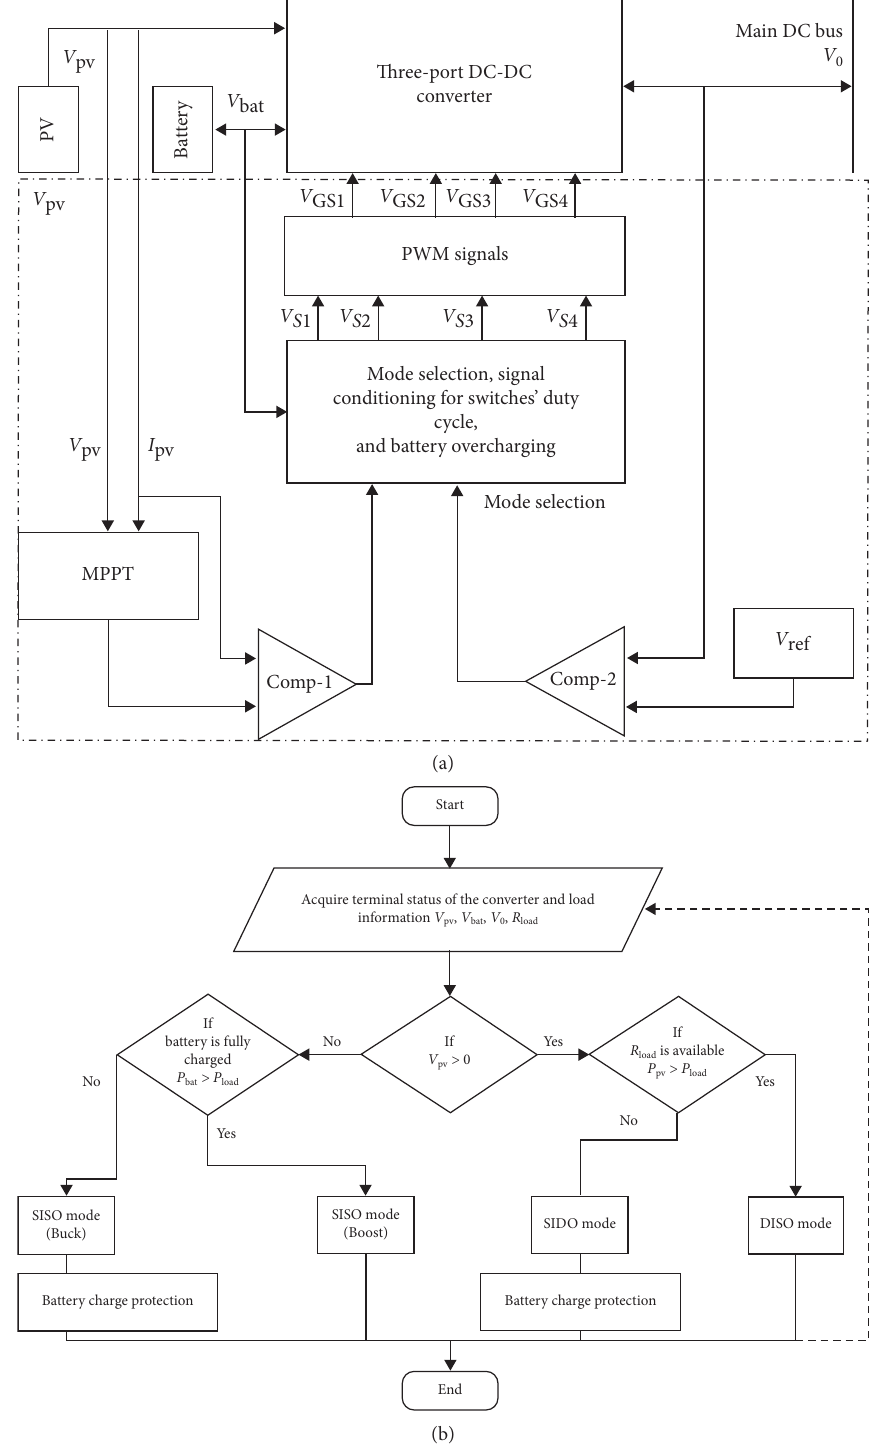
Figure 9: (a) Control system block diagram. (b) Control flow